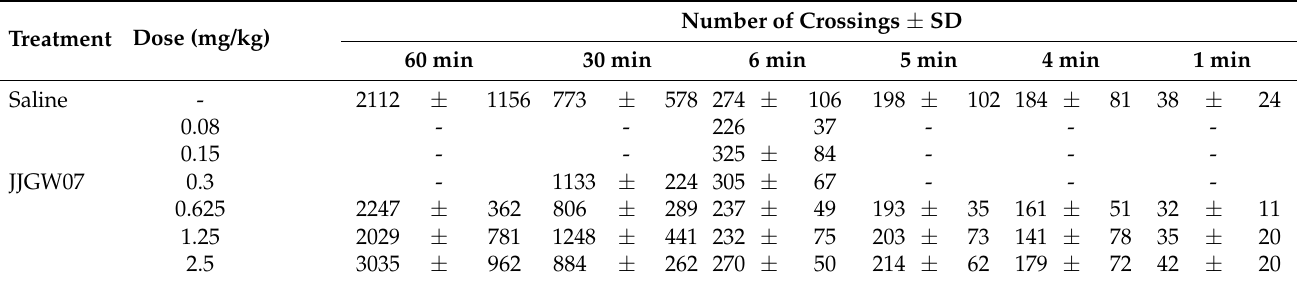
Table 2. The influence of JJGW07 on the locomotor activity in mice.